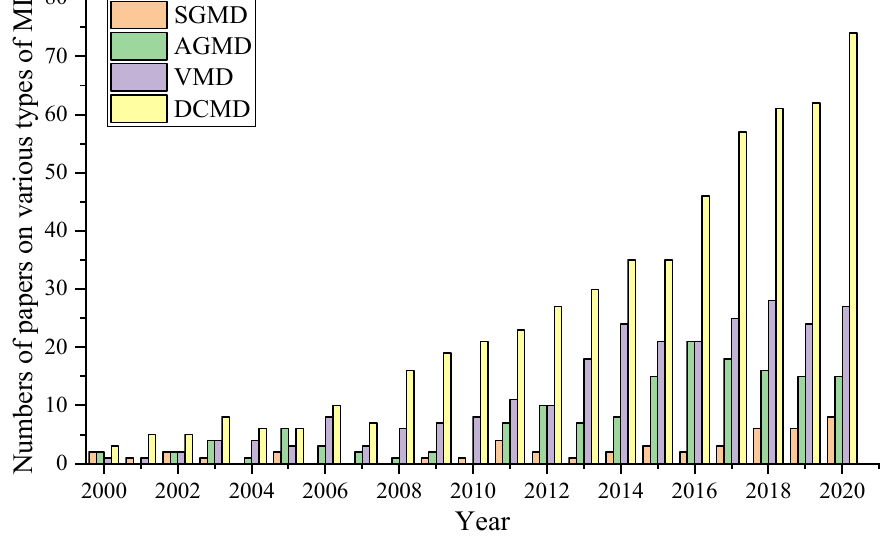
Figure 1. Number of publications on “membrane distillation” (searched with keywords “membrane distillation”, “DCMD” (direct contact membrane distillation), “VMD” (vacuum membrane distillation), “AGMD” (air gap membrane distillation), “SGMD” (sweeping gas membrane distillation)) from 2000 to 2020 (data taken from Science Direct database).